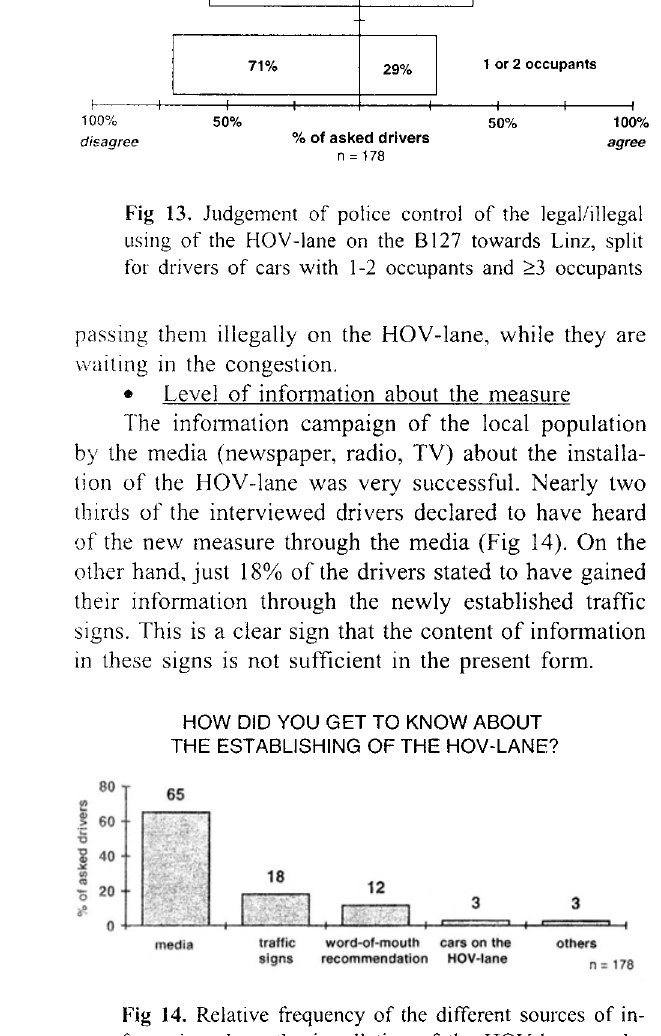
Fig 13. Judgement of police control of the legal/illegal using of the HOY-lane on the 8127 towards Linz, split for drivers of cars with 1-2 occupants and ~3 occupants passing them illegally on the HOY-lane, while they are waiting in the congestion.